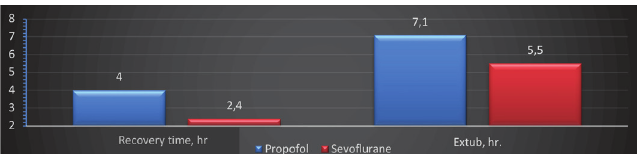
Figure 6 - Energy expenditure during CABG surgery.